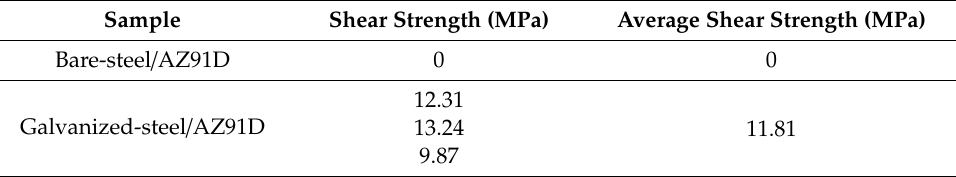
Table 4. The shear strength of galvanized-steel/AZ91D bimetallic material.